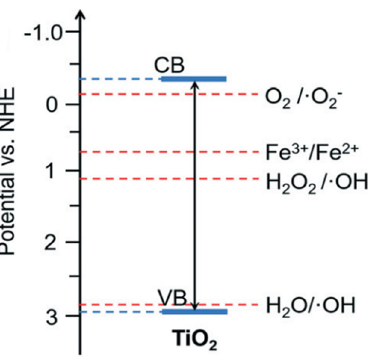
Figure 28. Methanol selectivity for different semiconductors [27]. Reproduced with permission from Zeng et al. Copyright © 2022 The Royal Society of Chemistry.